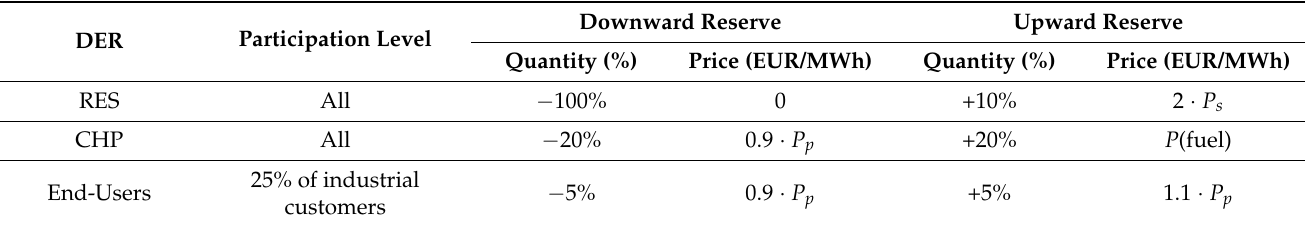
Table 2. DER participation in the market: quantity/price pairs.